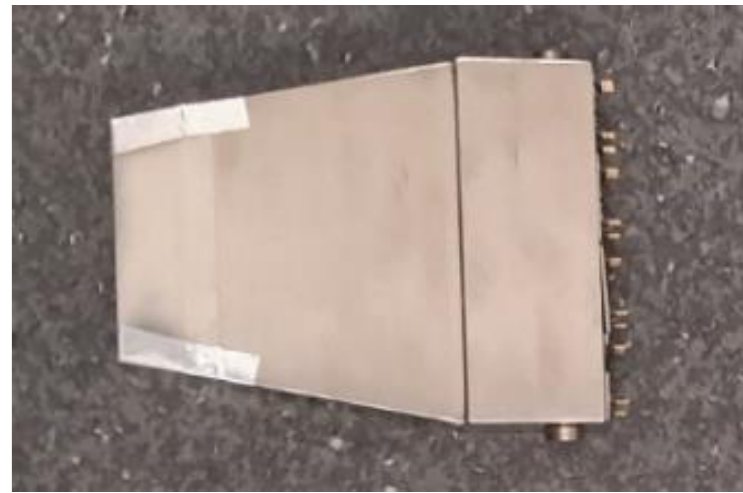
Figure 3. MicroPET cassette as used in constructing MicroPEPT: the four LSO crystals on the left of the picture are connected via light guides to position sensitive PSDs on the right.